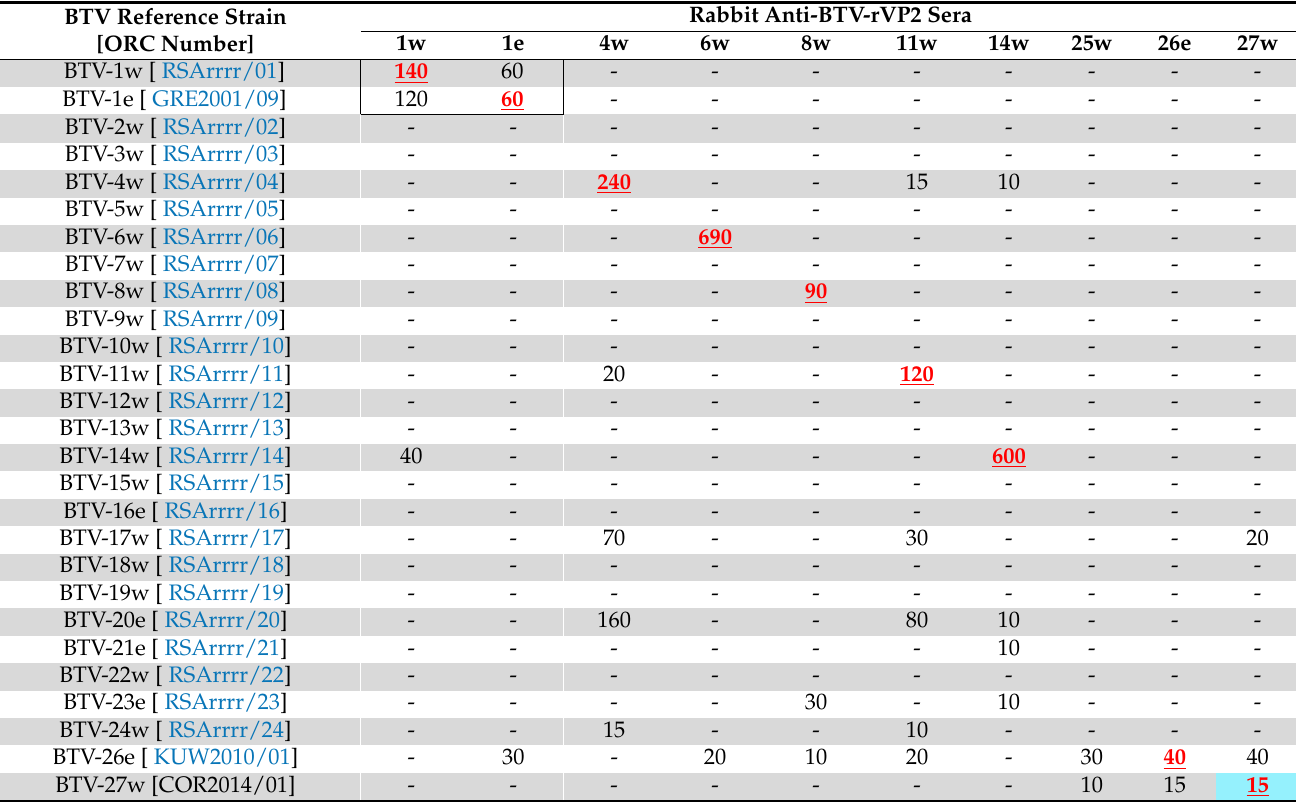
Table 3. Neutralising antibody (nAb) titres of rabbit anti-BTV-rVP2 sera in SNT. BTV Reference